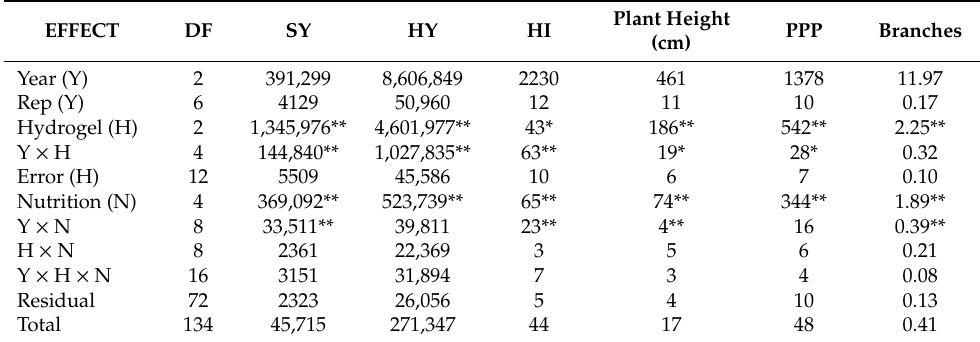
Table 1. Analysis of variance for plant growth and yield related characters under di ff erent treatment combinations involving hydrogel and